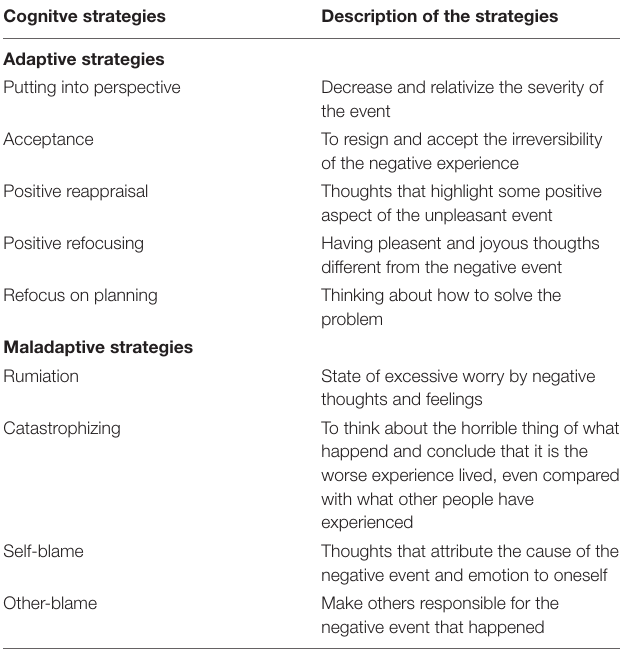
TABLE 3 | Cognitive strategies of the CERQ. Cognitve strategies Description of the